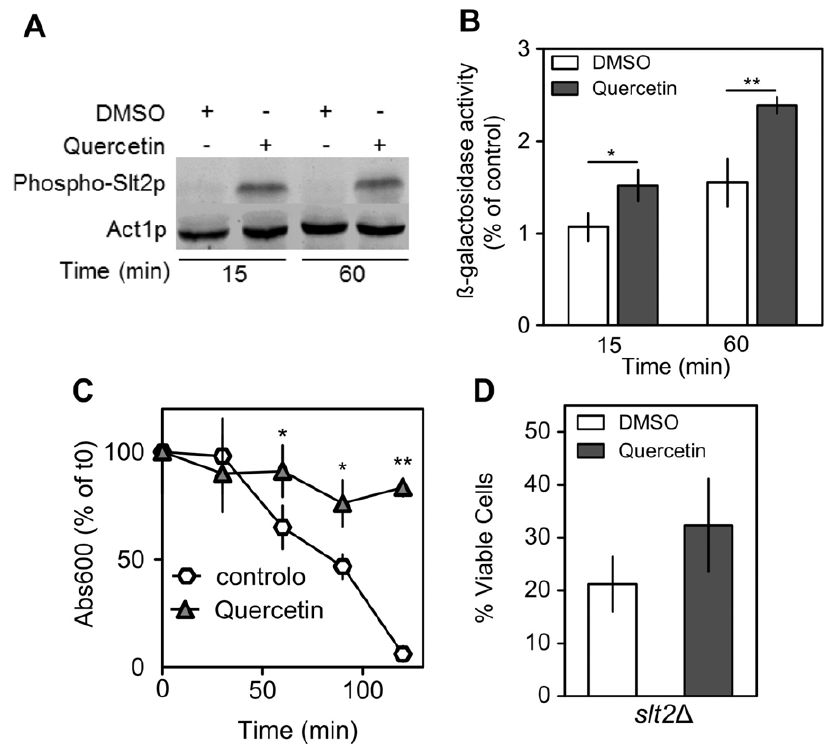
Figure 5. Quercetin activates the cell wall integrity signaling pathway. (A) Phospho-Slt2 protein levels. S. cerevisiae BY4741 cells were grown to exponential phase and treated with 300 m M of quercetin or equal volume of DMSO for the indicated time periods. Proteins were isolated, separated by SDS-PAGE, blotted into a membrane and incubated with anti-phospho-p44/42 antibody that detects dually phosphorylated Slt2p or with anti-actin antibody (loading control), as described in Materials and Methods . A representative blot is shown. (B) Rlm1p-transcription factor activity. Exponentially growing S. cerevisiae BY4741 cells transformed with a pRLM1-LacZ reporter construct were treated with 300 m M of quercetin or equal volume of DMSO (control) at the indicated times. b -galactosidase activity was determined as described in Materials and Methods and expressed as percentage of control cells. (C) Resistance to zymolyase digestion. S. cerevisiae BY4741 cells were treated with 300 m M of quercetin or equal volume of DMSO for 15 min and incubated with 0.25 U/ml zymolyase at 37 u C. Cell lysis was determined spectrophotometrically at 600 nm over time. (D) Hydrogen peroxide resistance of slt2 D cells was assessed as described in legend to Figure 4D. Values are mean 6 SD of at least three independent assays. **p , 0.01; *p , 0.05 (unpaired